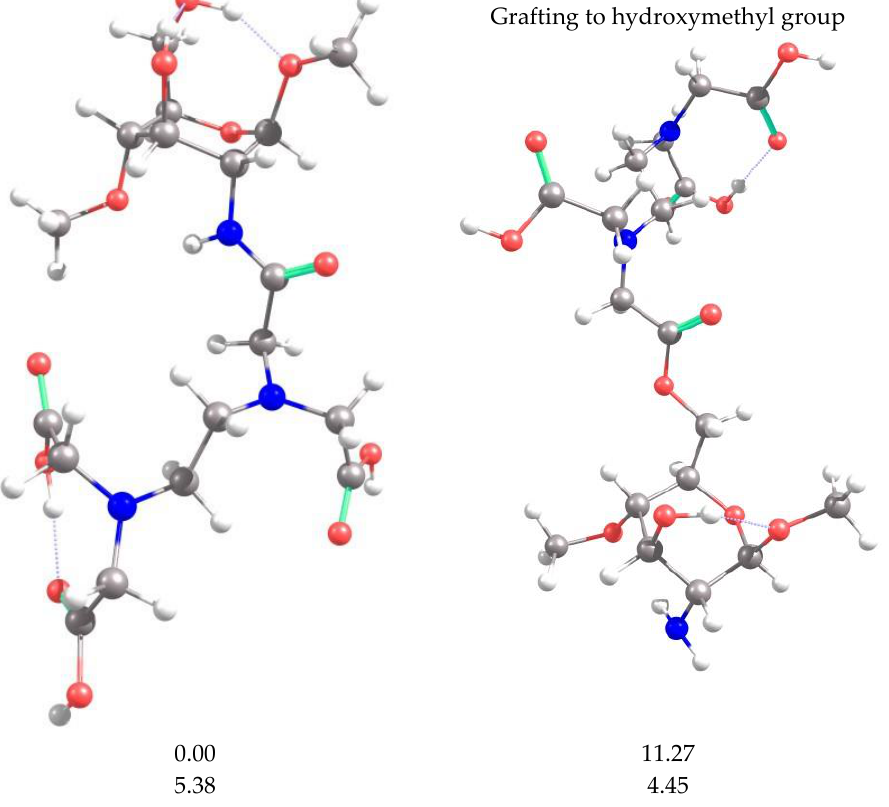
Figure 9. Spatial structures of EDTA grafted onto the CS unit and the corresponding values of the relative energy and dipole moment.